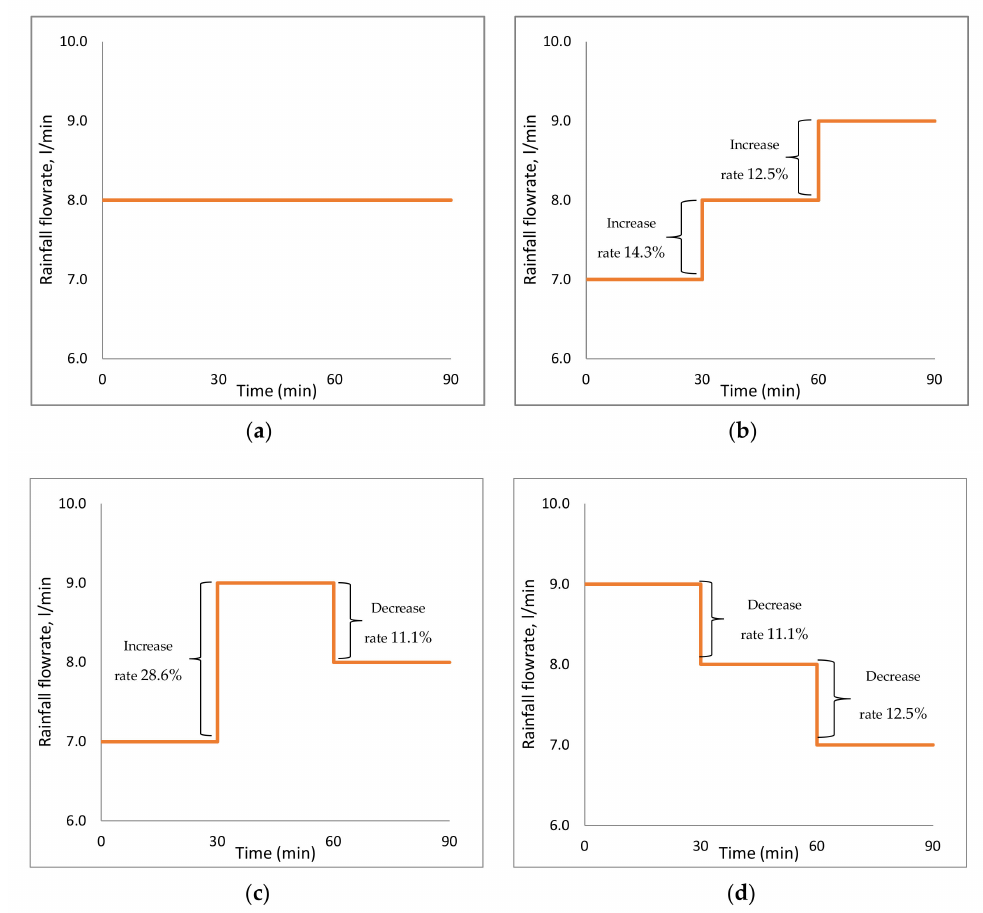
Figure 1. Four different rainfall patterns with their respective increasing and decreasing rates: